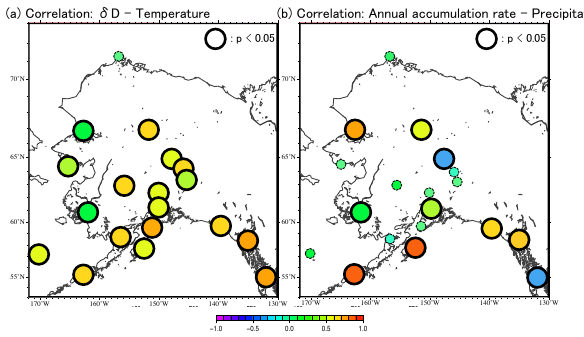
Figure 5. (a) Correlations between 7-year running-average stable hydrogen isotope ( δ D) values of the Aurora Peak ice core and 7-year running-average temperatures at the weather stations. (b) Correla- tions between 7-year running-average annual accumulation rates es- timated for the Aurora Peak ice core and 7-year running-average precipitation data at the weather stations. The thick black circles indicate sites that were statistically significant at the 95%